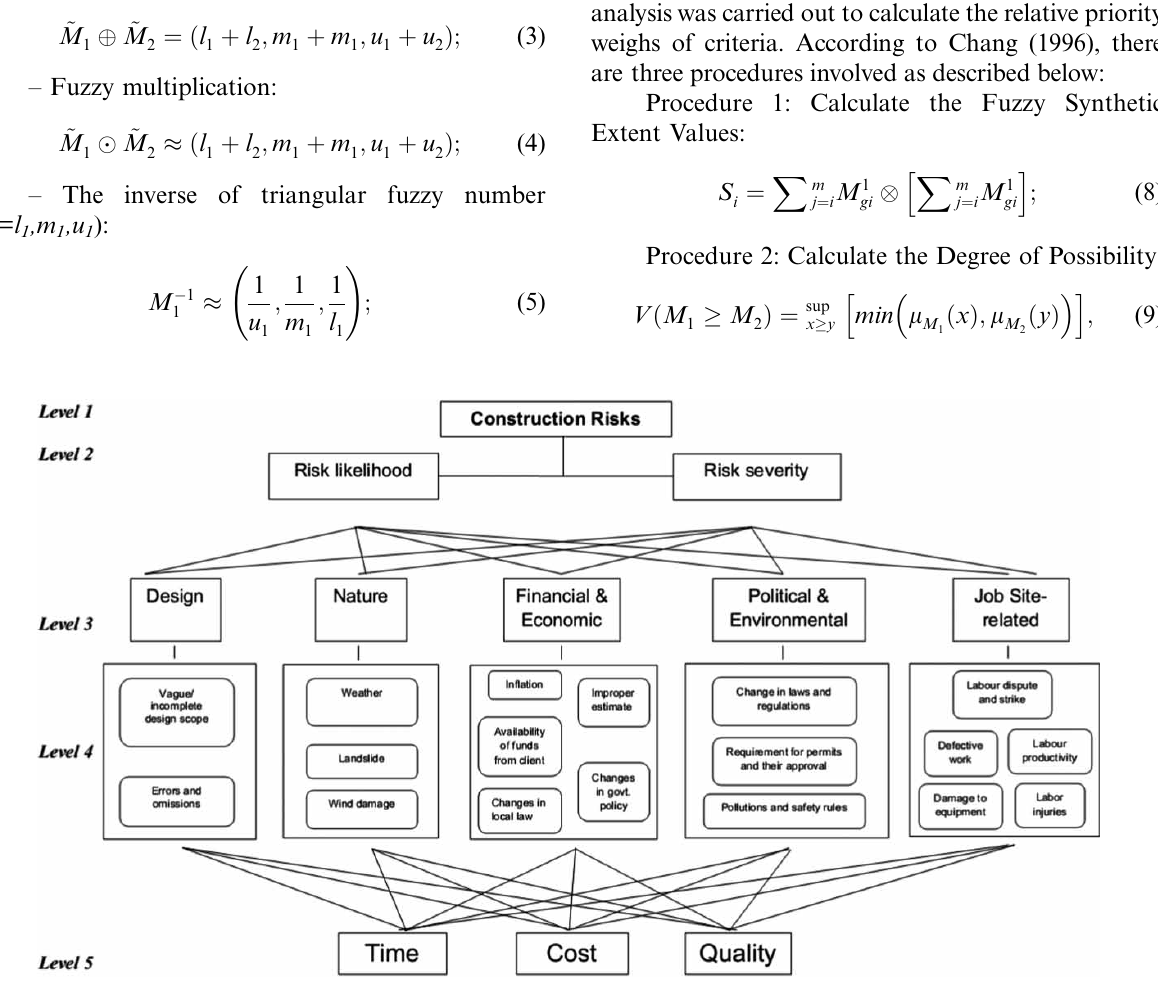
Fig. 4. Breakdown structure of construction project